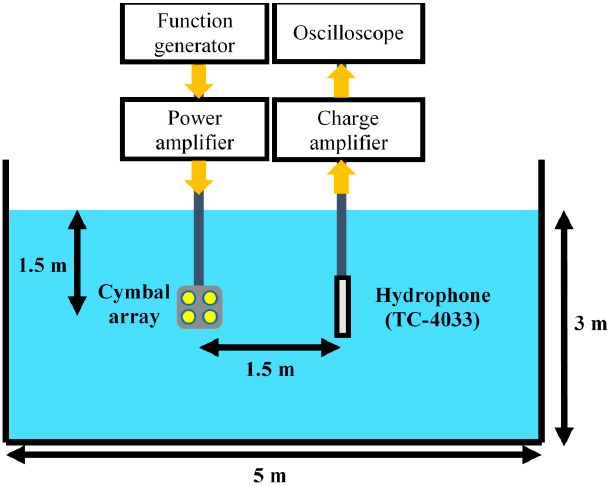
Figure 10. Schematic diagram of the underwater TVR spectrum measurement setup.